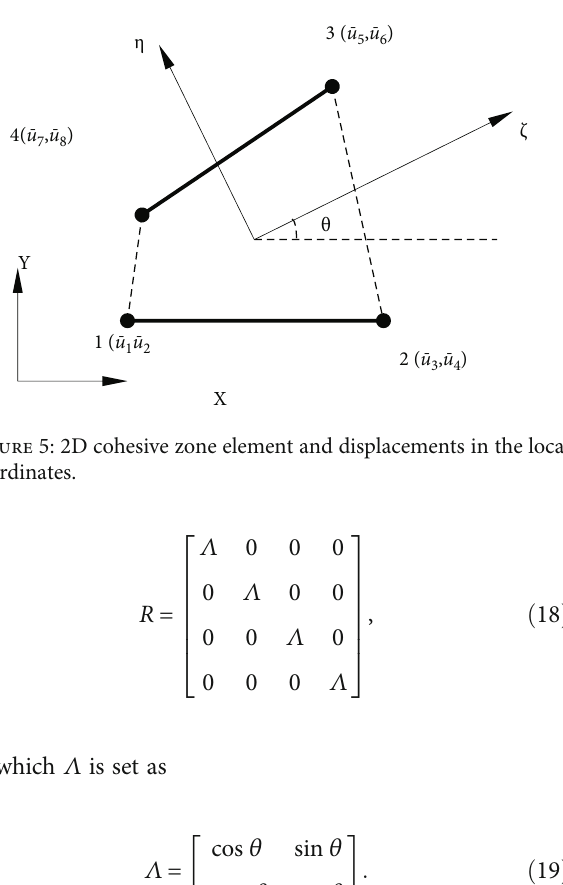
Figure 3: Exact functional boundary of the PPR CZM for (a) normal traction and (b) tangential traction (compression in not included).